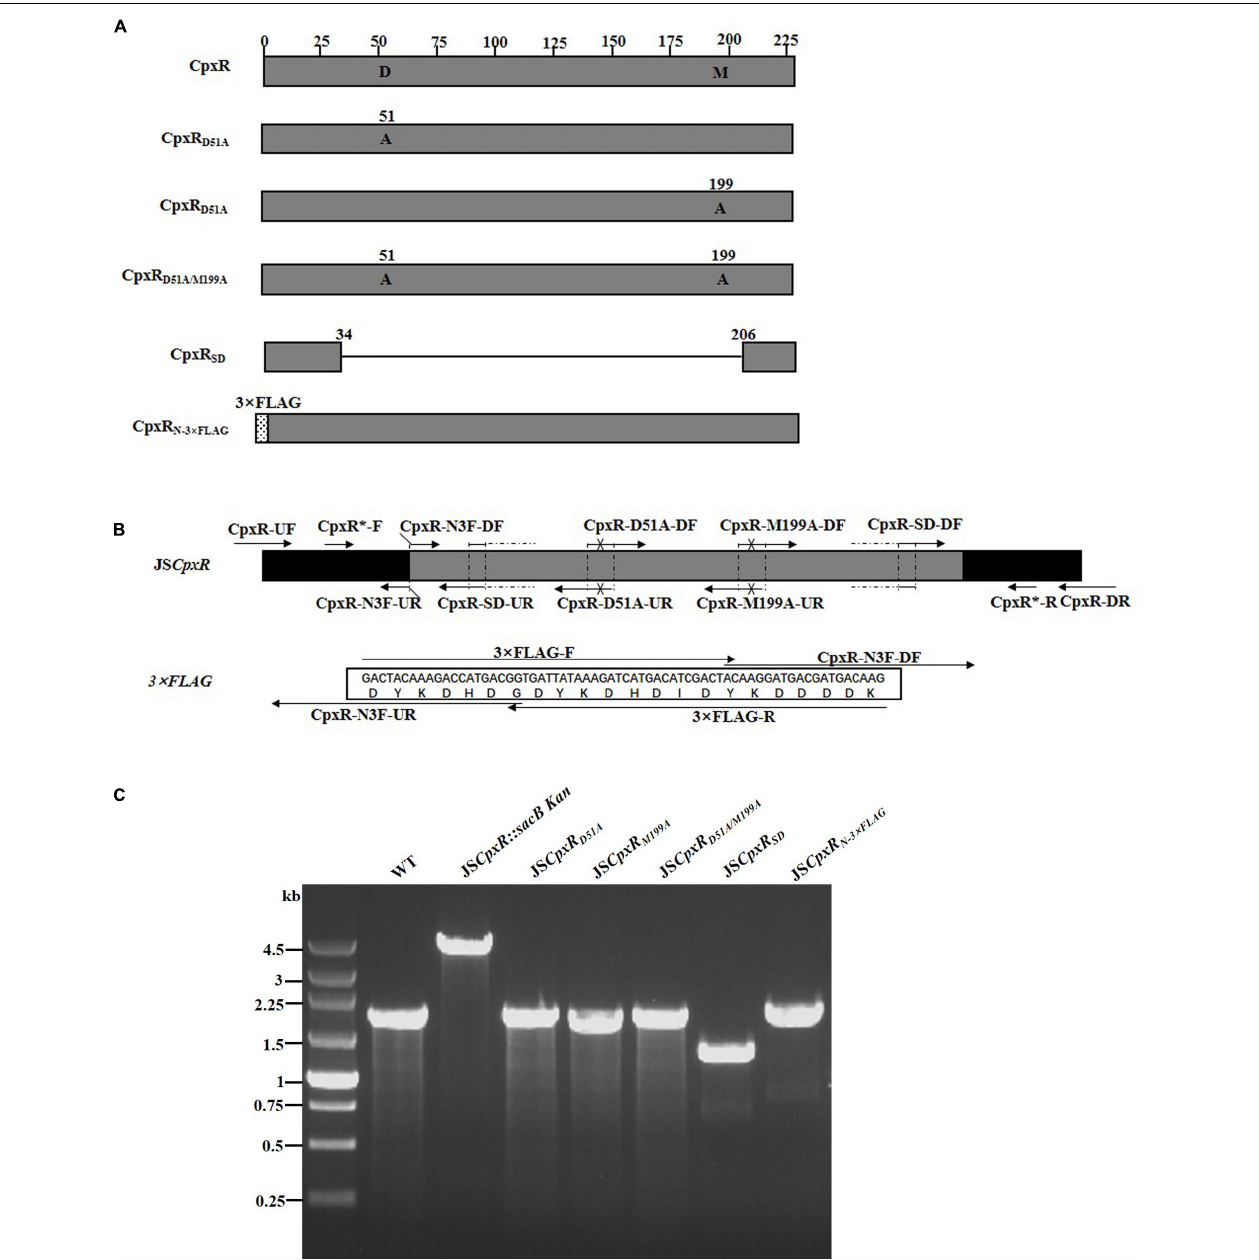
FIGURE 3 | Construction of different gene modifications of cpxR gene. (A) Schematic diagram of the gene structure of different cpxR gene modifications. JS CpxR D 51 A and JS CpxR M 199 A mutants include the point mutation at the 51st amino acid (D → A) and at 199th amino acid (M → A) of CpxR protein, respectively; the JS CpxR D 51 A / M 199 A mutant include double-point mutation at 51st and 199th amino acids of the CpxR protein; the JS CpxR SD mutant was seamlessly deleted in the major region of the CpxR protein. The JS CpxR N − 3 × FLAG strain expresses N-terminal 3 × FLAG-tagged CpxR protein. (B) Primer design for constructing a mutagenic substitution fragment. The universal primers are CpxR-UF/DR and CpxR-F*/R*, and the mutation primers are CpxR-D51A-DF/UR, CpxR-M199A-DF/UR, CpxR-SD-DF/UR, and CpxR-N3F-DF/UR. The overlapping region of CpxR-D51A-DF/UR includes the point mutation at codon 51 (GAC → GCC) of CpxR gene used to create the CpxRD51A point mutation fragment. The overlapping region of CpxR-M199A-DF/UR includes the point mutation at codon 199 (ATG → GCG) of the CpxR gene used to create the CpxR M 199 A point mutation fragment. Both primer pairs CpxR-D51A-DF/UR and CpxR-M199A-DF/UR were used to create the CpxR D 51 A / M 199 A mutation fragment. The overlapping region of CpxR-SD-DF/UR lacks the great mass of codons (34ATG → 206CGC) used to create the CpxR SD deletion mutation fragment. The primers 3 × FLAG-F/R are two complementary oligonucleotides used to create 3 × FLAG tag fragment. The primers CpxR-N3F-DF and CpxR-N3F-DF both include the overlapping region with the 3 × FLAG tag fragment used to create the N-terminal tagging CpxR fragment. (C) PCR analysis of CpxR multiple mutants. Band sizes: WT, 1.88 kb; intermediate strain (JS CpxR:sacBKan ), 4.40 kb; final strain (JS CpxR D 51 A ), 1.88 kb; final strain (JS CpxR M 199 A ), 1.88 kb; final strain (JS CpxR D 51 A / M 199 A ), 1.88 kb; final strain (JS CpxR SD ), 1.32 kb; final strain (JS CpxR N − 3 × FLAG ), 1.94 kb. Molecular size markers (250 bp DNA ladder marker, Takara) are indicated. WT, wild